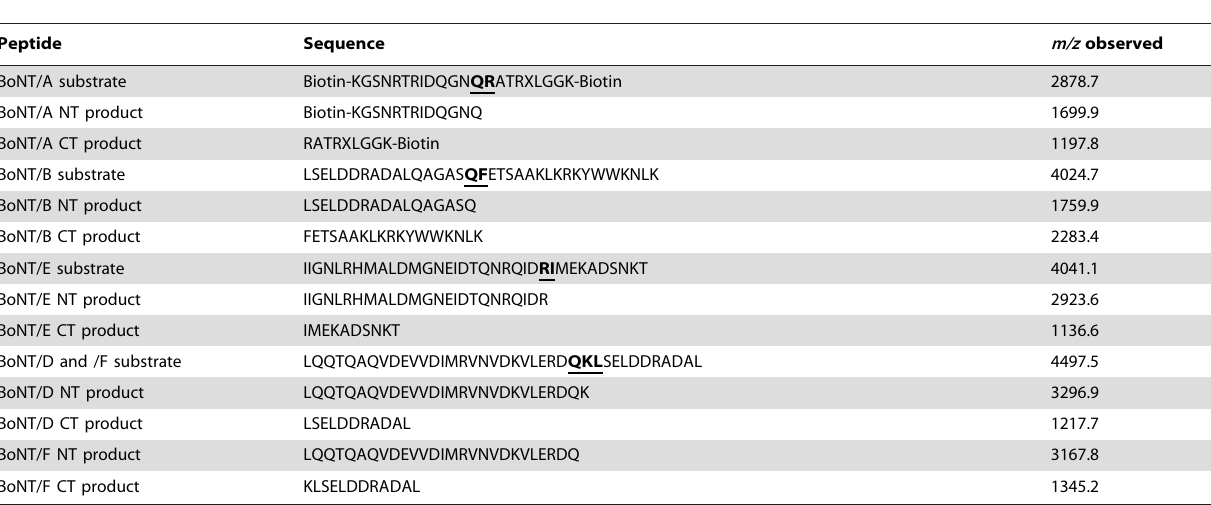
Table 1. Amino acid sequence of peptides used in and produced by the Endopep-MS